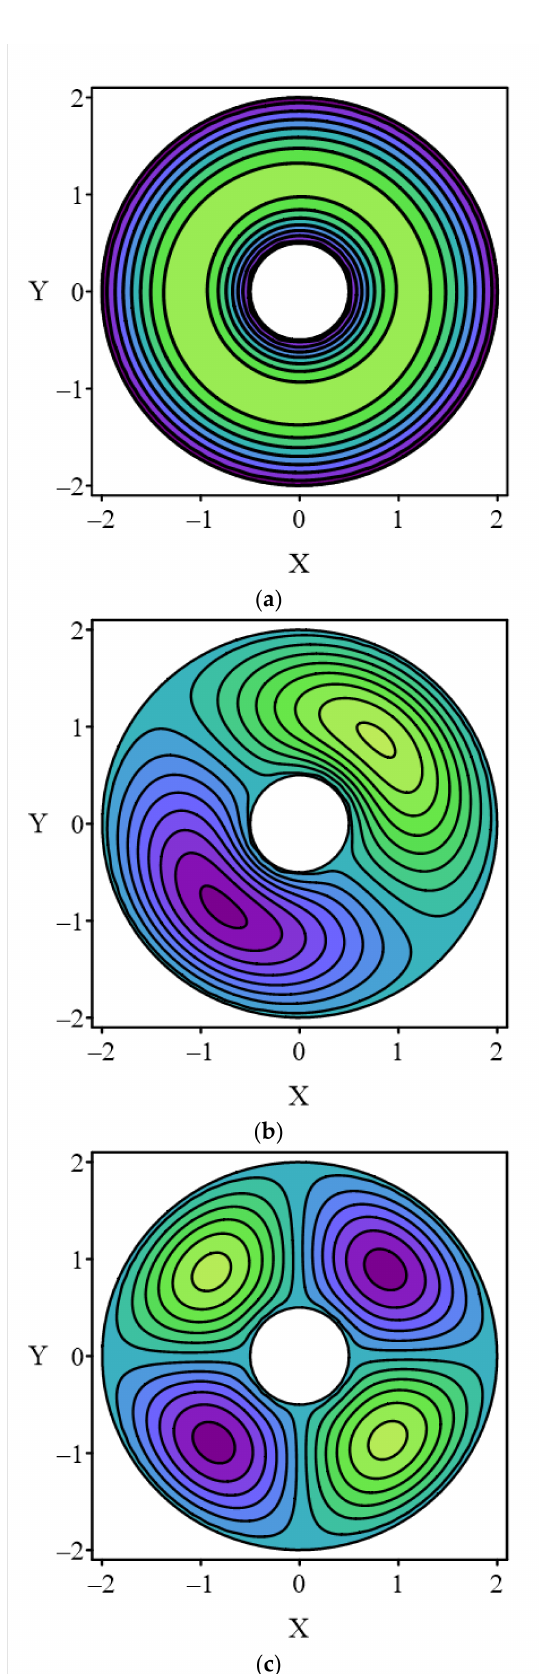
Figure 7. The first three eigenmodes for concentric annular waveguide (TM wave): ( a ) k 1 = 2.0488, ( b ) k 2 = 2.2237, and ( c ) k 3 =